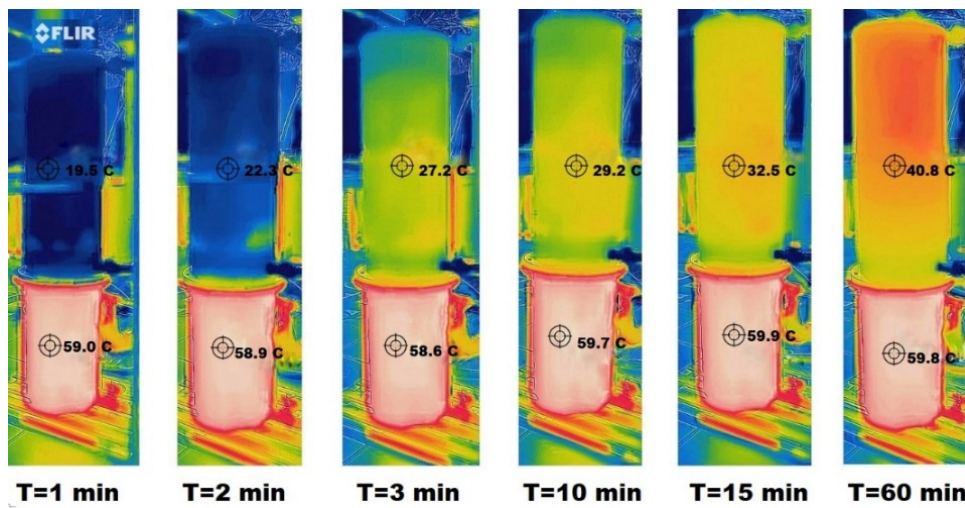
Figure 5. Photos with FLIR thermal camera during test no. 1.